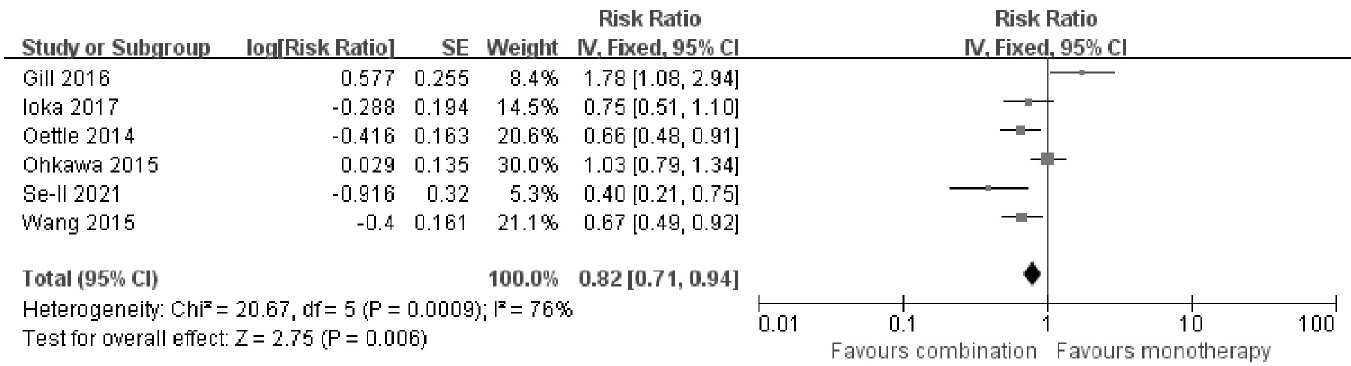
Fig 2. Comparison of OS between fluoropyrimidine combination therapy and fluoropyrimidine monotherapy. SE: Standard error. CI: Confidence interval. IV: Inverse variance. Diamonds represented the 95% confidence interval of overall effect.